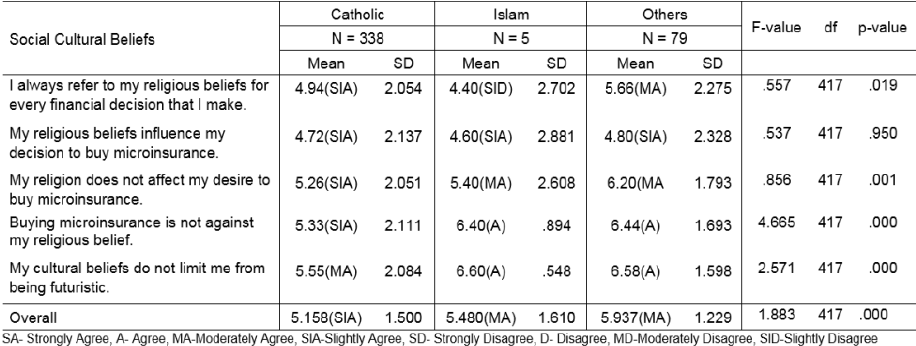
Analysis of the data (Table 6) reveals that significant differences exist in the overall level of agreement of the respondents on